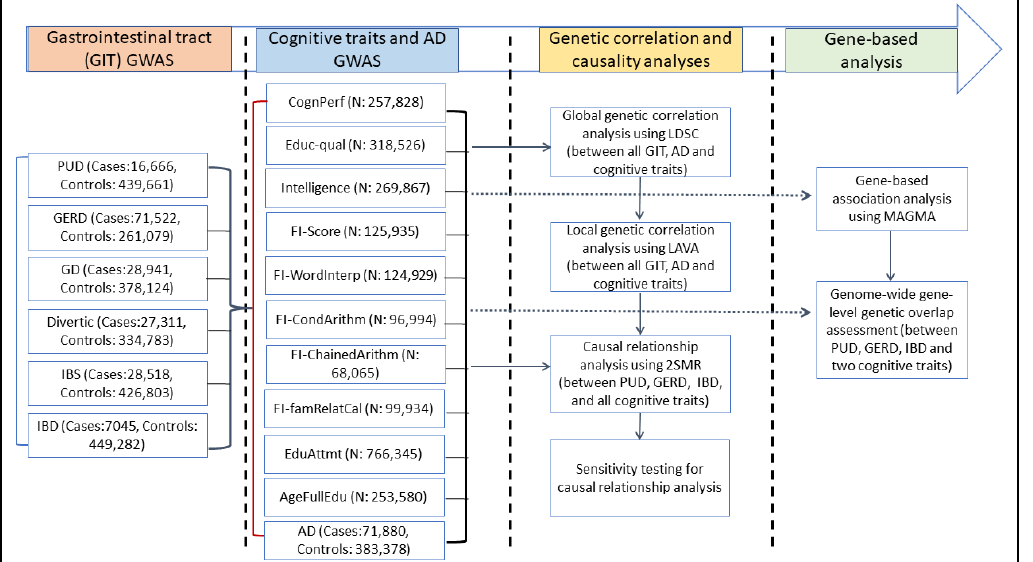
Figure 1. Study design and workflow: examining the relationship of cognitive traits and AD with GIT disorders. AD: Alzheimer’s disease, IBS: irritable bowel syndrome, PUD: peptic ulcer disease, GERD: gastroesophageal reflux disease, IBD: inflammatory bowel disease, GD: gastritis-duodenitis, Divertic: diverticulosis, AgeFullEdu: age completed full-time education, FI-ChainedArithm: fluid intelligence-chained arithmetic, FI-CondArithm: fluid intelligence-conditional arithmetic, FI-famRelatCal: fluid intelligence-family relationship calculation, FI-WordInterp: fluid intelligence-word interpolation, CognPerf: cognitive performance, Educ-qual: educational qualification, EduAttmt: educational attainment. GWAS: genome-wide association studies, GIT: gastrointestinal tract, LDSC: linkage disequilibrium score regression, LAVA: local analysis of [co]variant association, MAGMA: multi-marker analysis of genomic annotation, 2SMR: two-sample Mendelian randomisation.